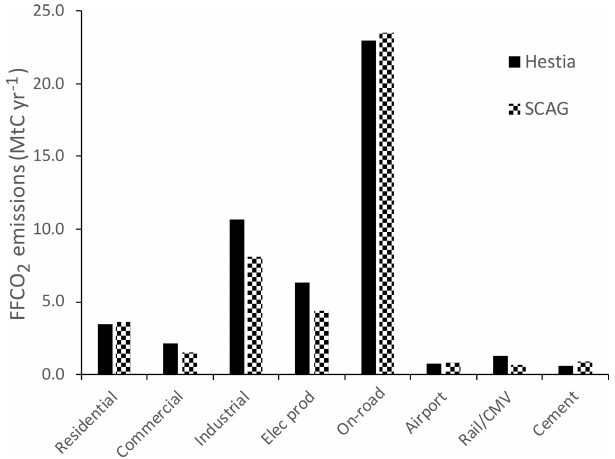
Figure 14. Comparison of sector-specific FFCO 2 emissions for the year 2010 between the Hestia-LA and SCAG estimates. Units: MtCyr − 1